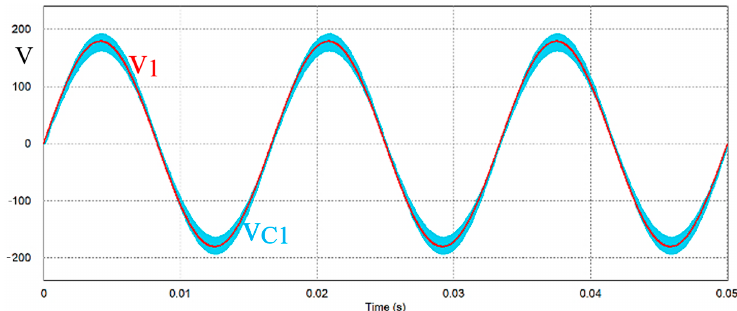
Figure 6. Output voltage V o , input voltage (v 1 ), and current (i 1 ).